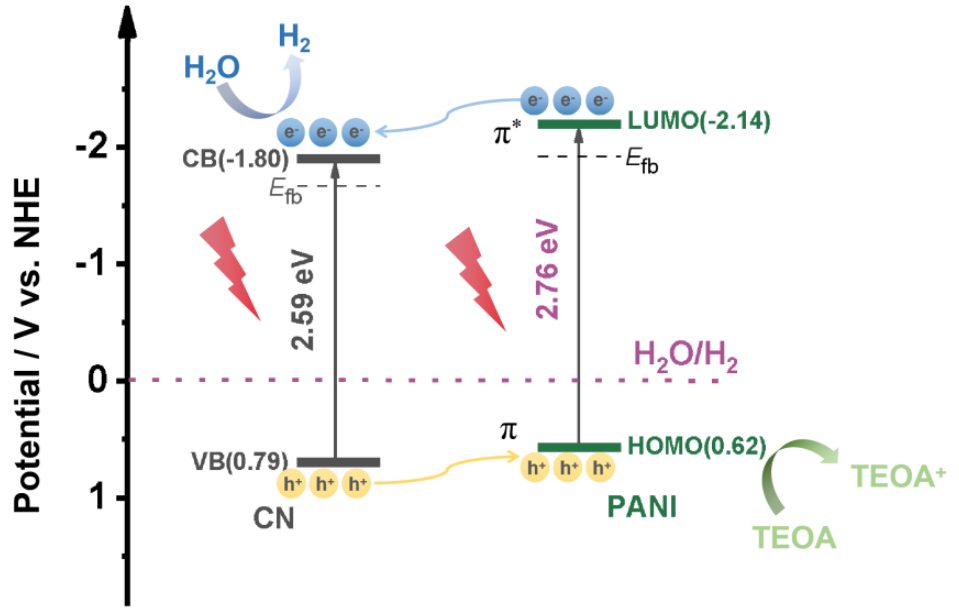
Figure 8 . The schematic illustration for electronic energy-band structure and photocatalytic H 2 evolution improvement mechanism of CN/PANI heterojunction film under visible light irradiation.